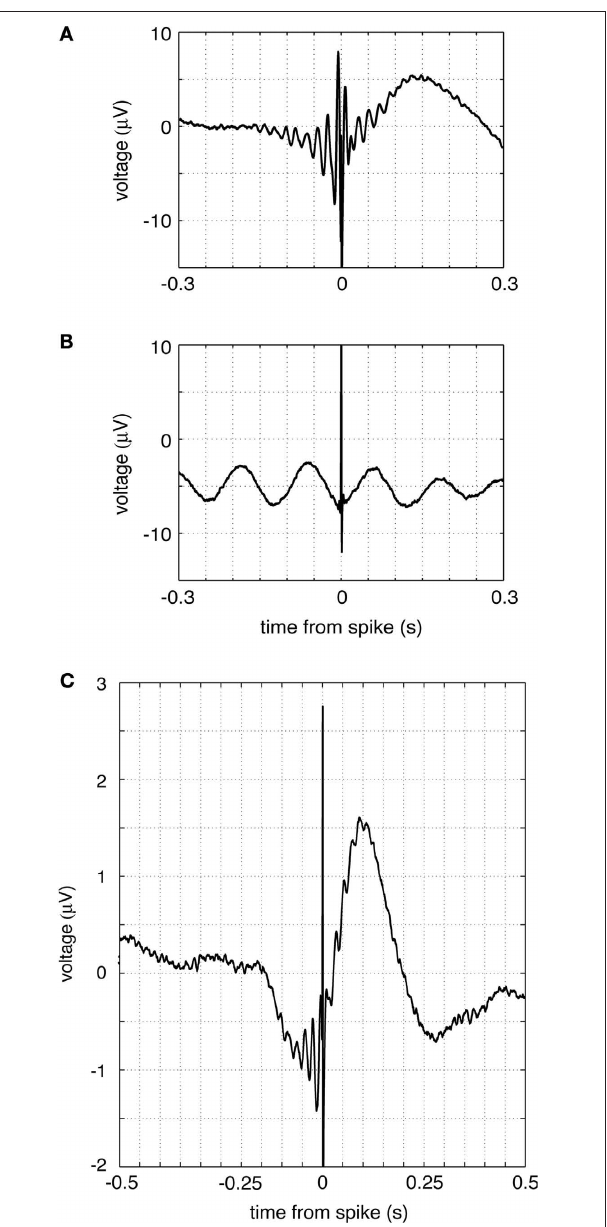
FIGURE 10 | Gamma-50 and gamma-80 power are differentially modulated before turnaround points on the central segment of the maze, in the absence of reward. (A) Gamma-50 power was briefl y elevated shortly before turnaround (thin vertical line at time 0), while gamma-80 power (grey line) did not show sharp peaks but was higher overall before turnaround compared to after (B) . The animals’ average speed indicated an onset of movement at the time of turnaround (C) . the phase of each spike relative to gamma-50 and gamma-80 were